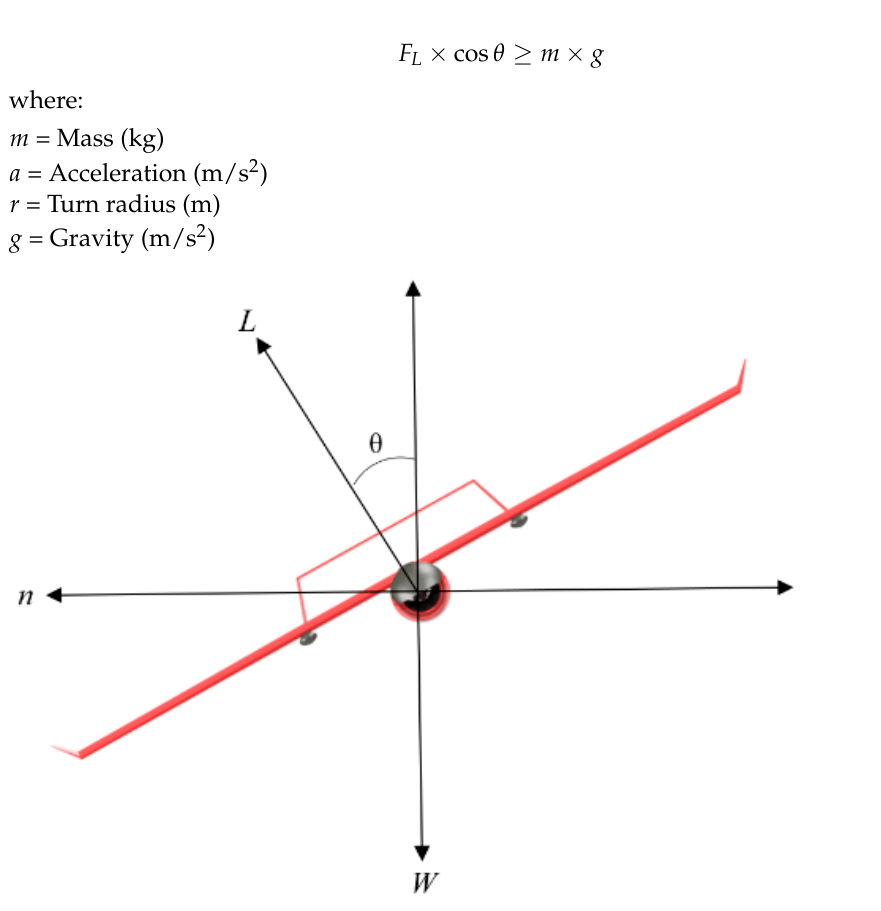
Figure 8. Free body diagram of the aircraft.